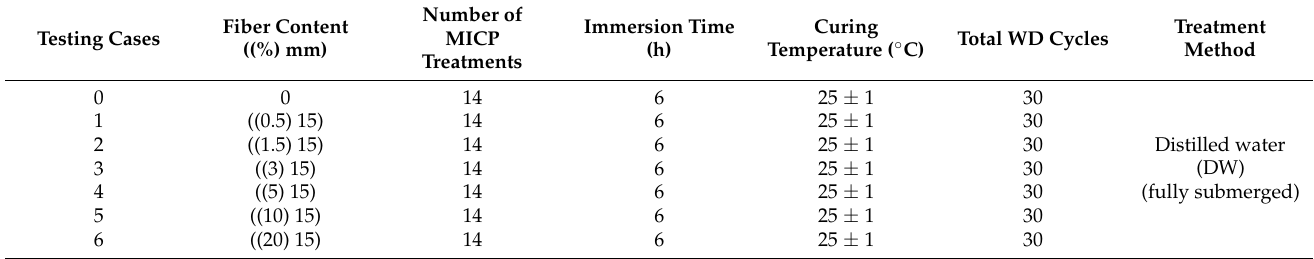
Table 2. Testing conditions used in this study for durability analysis (DW cases).